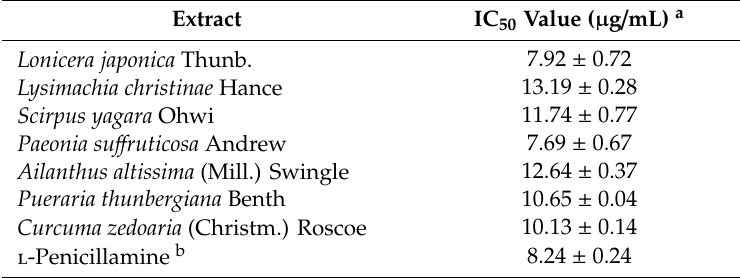
Table 2. ONOO − scavenging activity of 70% EtOH extract from Korean medicinal